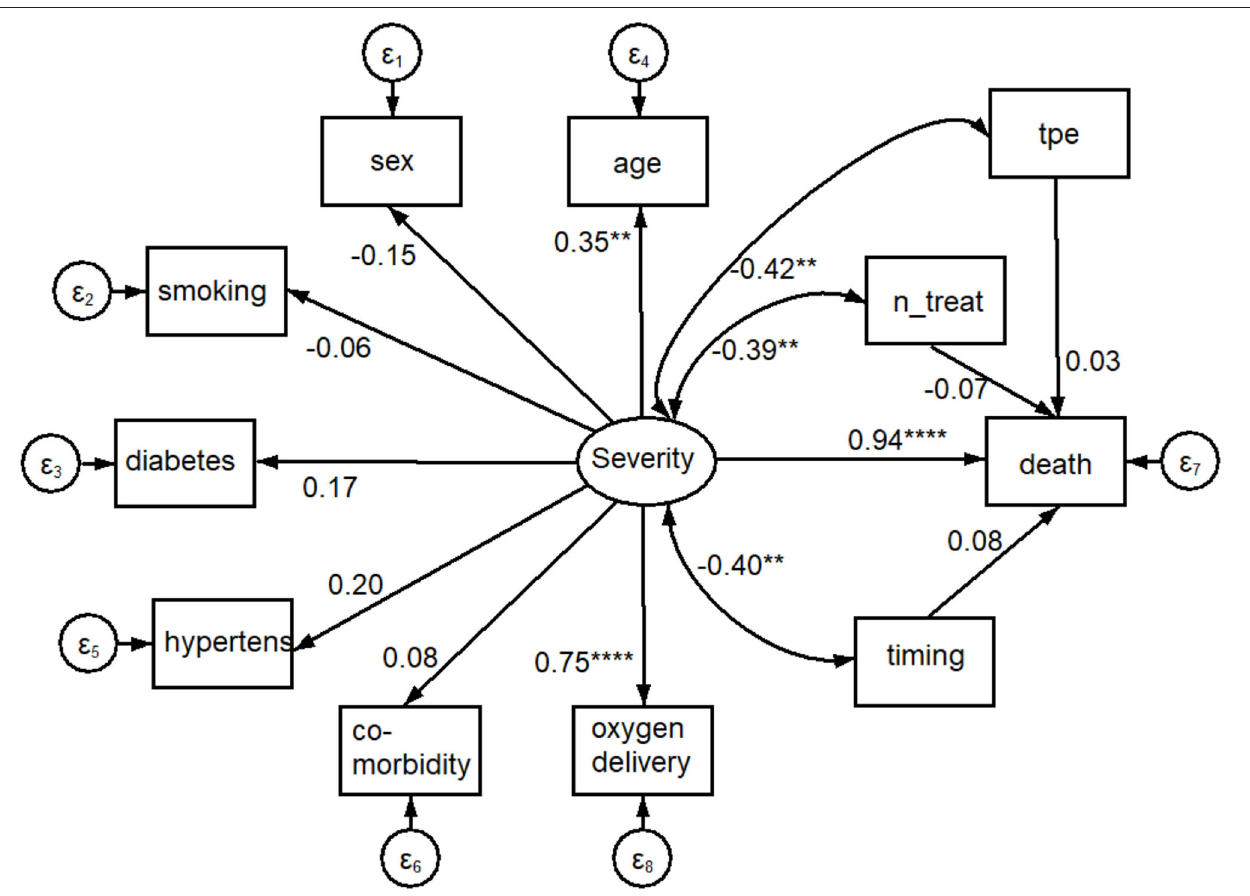
FIGURE 4 | Path diagram of results shown in Table 3 . An oval indicates the latent variable (Severity, square boxes indicate the observed variables, circles indicate errors, arrows specify the direction of causal flow, an arrowed route is a path, curved paths express covariances, and the estimated beta coefficients appeared along the paths. It can be seen that: Severity is significantly associated with O 2 delivery ( p = 0.000) and age ( p = 0.002); there is a negative correlation between Severity and plasmapheresis (“tpe,” p = 0.003), number (“n_treat,” p = 0.006) and timing (“timing,” p = 0.005) of its administration; the impact on mortality (the dependent variable “death”) was highest for Severity ( p = 0.000) and close to 0.0 for plasmapheresis variables. **** p < 0.001, ** p < 0.01.